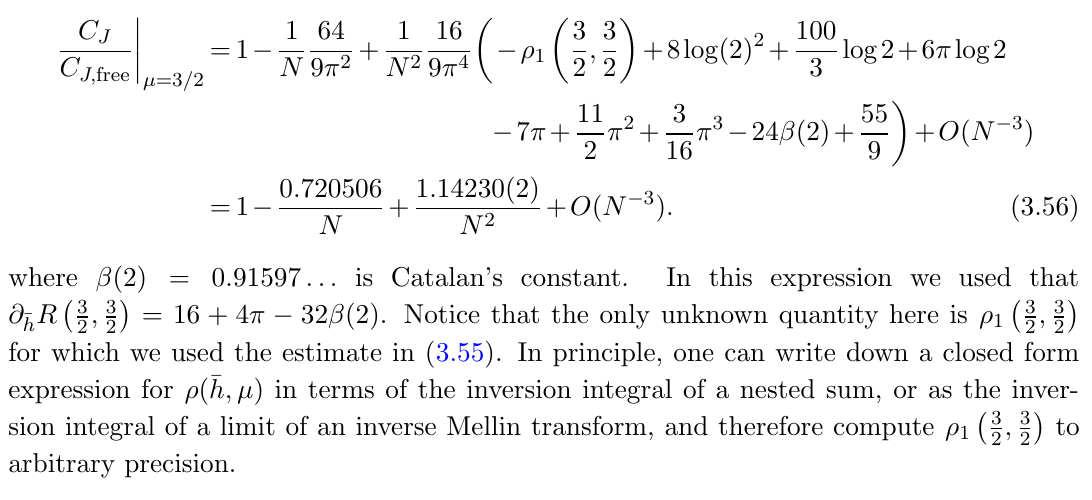
Figure 1 . The numeric estimate for the 1 =N 2 correction c (2) current charge C J =C J; free in the interacting and in the free